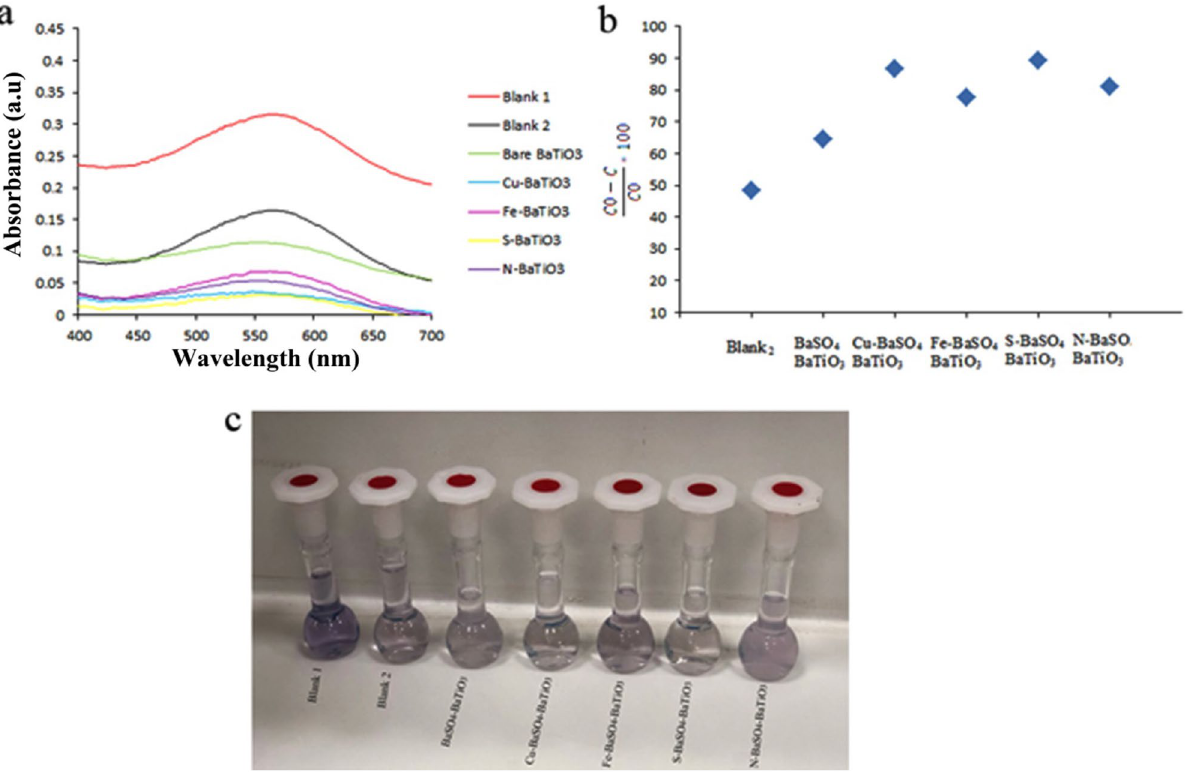
Figure 9. ( a ) The UV–Vis spectrum of initial AB113 (blank 1), AB113 after treat it with bare ultrasonic (blank 2), BaSO